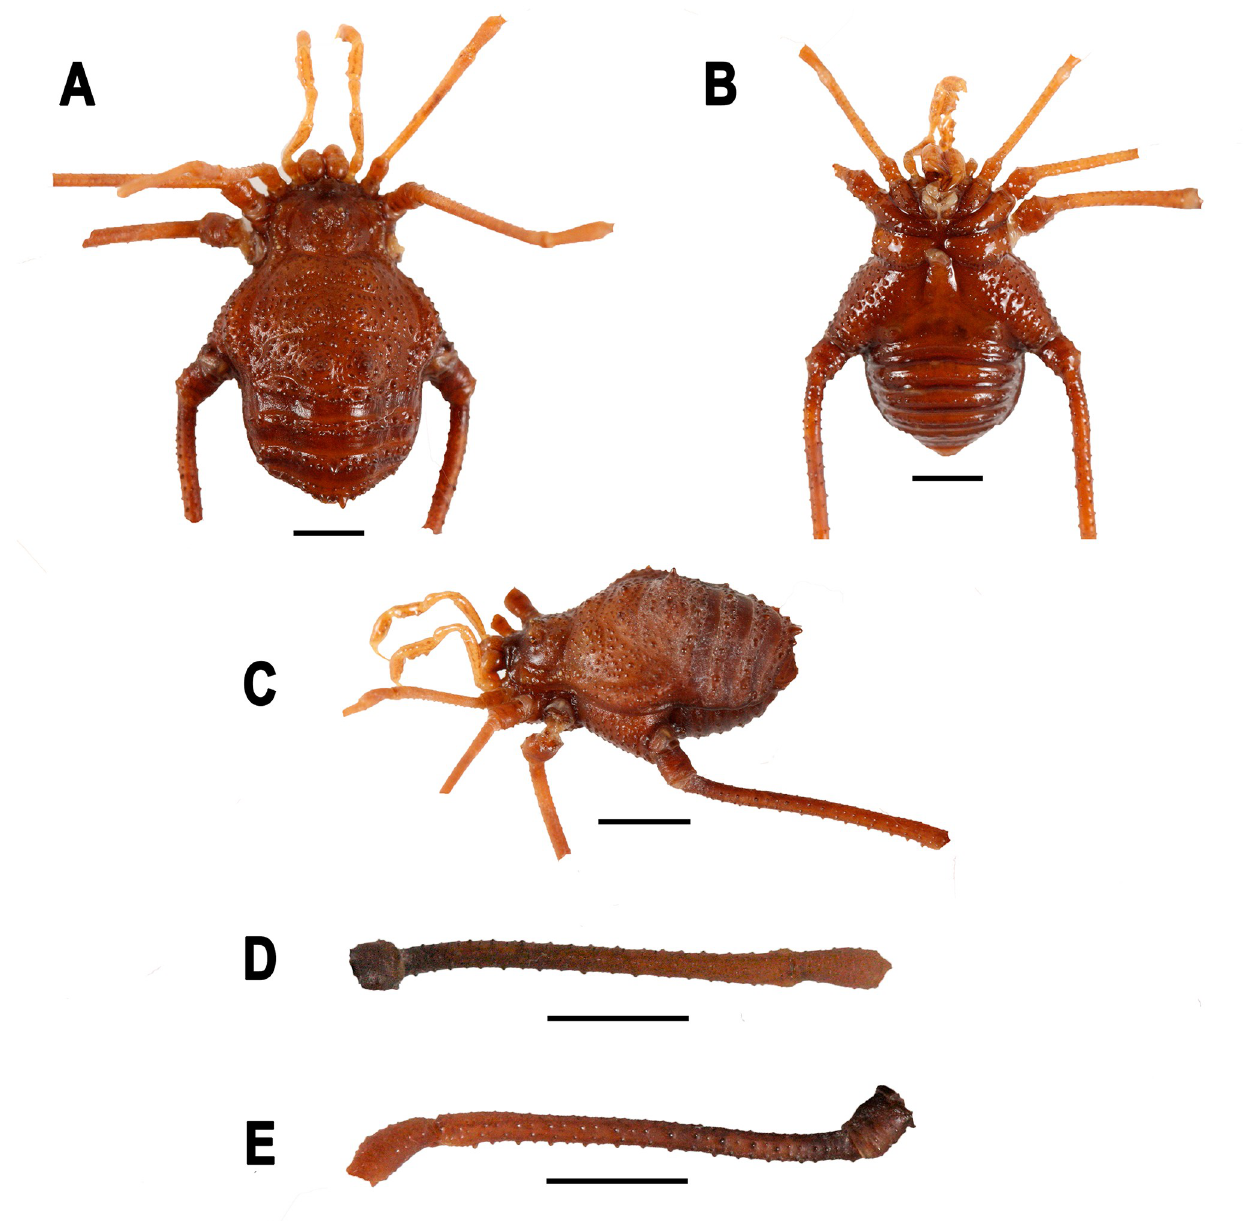
Fig 7. Neosadocus robustus ( Ilhania robusta female paralectotype, MNRJ 42289). A. Dorsal view. B. Ventral view. C. Left lateral view. D–E. Right trochanter–patella IV (D: retrolateral view; E: prolateral view). Scale bars: 3 mm.